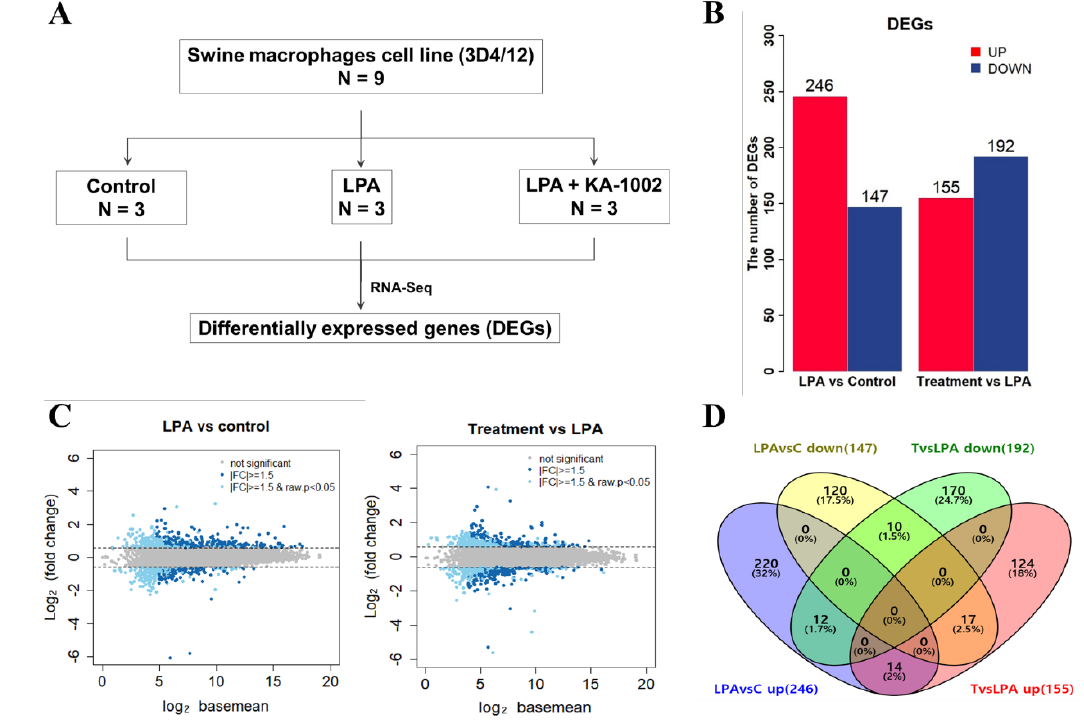
Figure 1. ( A ) Sample preparation for RNAseq. ( B ) Number of upregulated and downregulated di ff erentially expressed genes (DEGs) in lysophosphatidic acid (LPA) treated swine macrophages in comparison with untreated swine macrophages (control) and DEGs in LPA + KA-1002 treated swine macrophages(treatment) in comparison with LPA treated swine macrophages (LPA). DEGs were selected by a fold change cut-o ff of > 1.5 and p -value < 0.05. ( C ) Scatter dot plot indicating di ff erentially expressed genes (DEGs) between LPA vs. control group and treatment (LPA + KA-1002) vs. LPA group. The Y axis shows fold changes in expression level (log2 value), and the X axis depicts volume. The volume indicates the level of gene expression. The volume was calculated by geometric means of mapped reads between two conditions. ( D ) Venn diagram showing relations of DEGs between LPA vs control and Treatment vs LPA